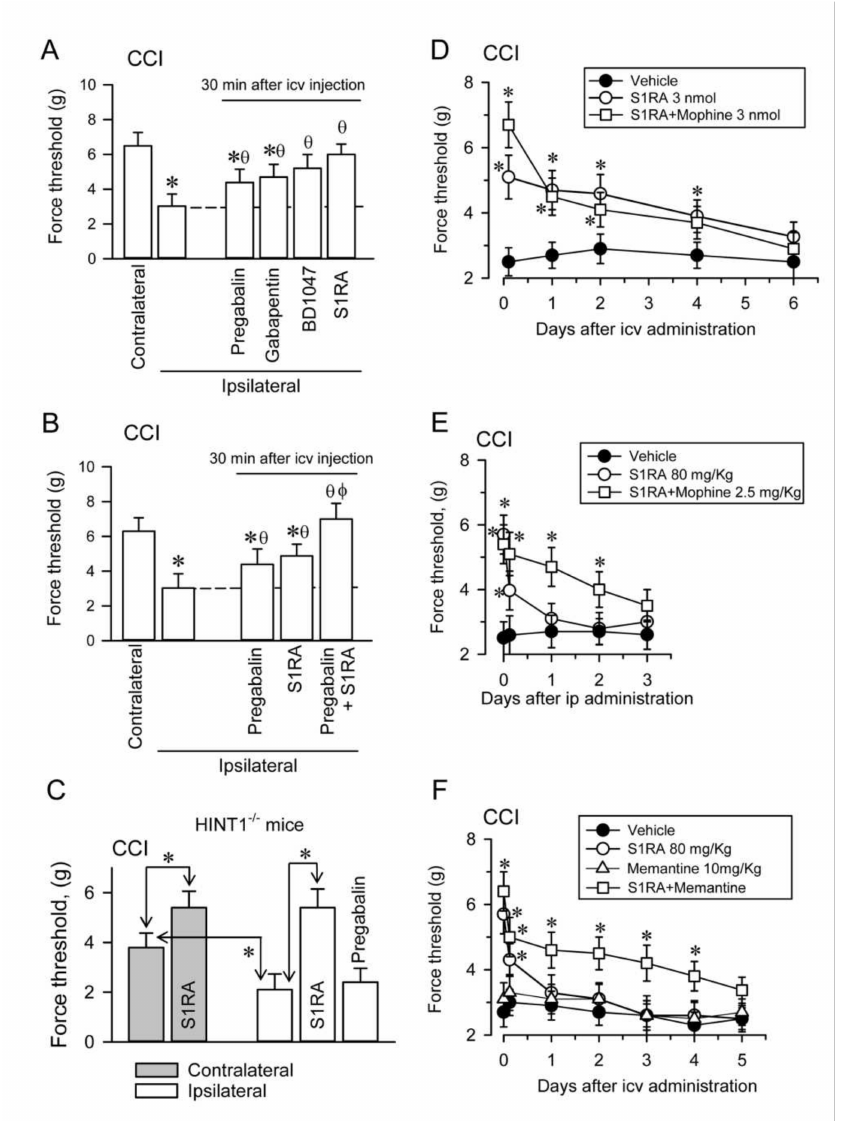
Figure 10. Effect of σ 1R ligands and gabapentinoids on the mechanical allodynia displayed by mice. Paw withdrawal thresholds were measured 7 days after CCI surgery and the force (in grams) at which the mice withdrew their paws in response to von Frey hair stimulation was determined as an index of mechanical allodynia. Pharmacological interventions were performed 7 days after CCI. ( A ) Anti-allodynia compounds (3 nmol) were injected intracerebroventricularly (icv) into CD1 WT mice and their effect was evaluated 30 min later. The dashed line indicates the allodynic effect on the ipsilateral paw: * significantly different relative to the contralateral paw; θ indicates significantly different relative to the ipsilateral paw treated with vehicle (groups of 8 mice each). ( B ) CD1 WT mice. Synergic effect of pregabalin (2 nmol, icv) and S1RA (1 nmol, icv) on CCI-induced mechanical allodynia. * Significantly different relative to the contralateral paw; θ significantly different relative to the ipsilateral paw treated with vehicle; F significantly different relative to the ipsilateral paw treated with pregabalin or S1RA (groups of 8 mice each). ( C ) S1RA and pregabalin (3 nmol, icv) were administered to 129 HINT1 − / − mice and mechanical allodynia was evaluated 30 min post-injection: * indicates significant differences (groups of 8 mice each). ( D ) The σ 1R antagonist S1RA was